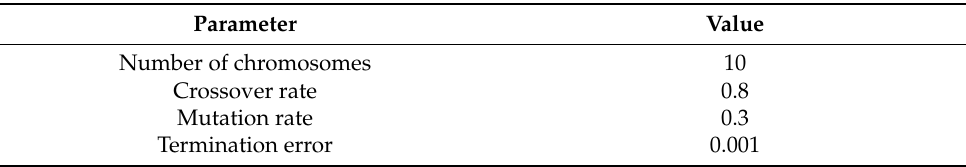
Table 5. Parameters of GA model used for optimisation